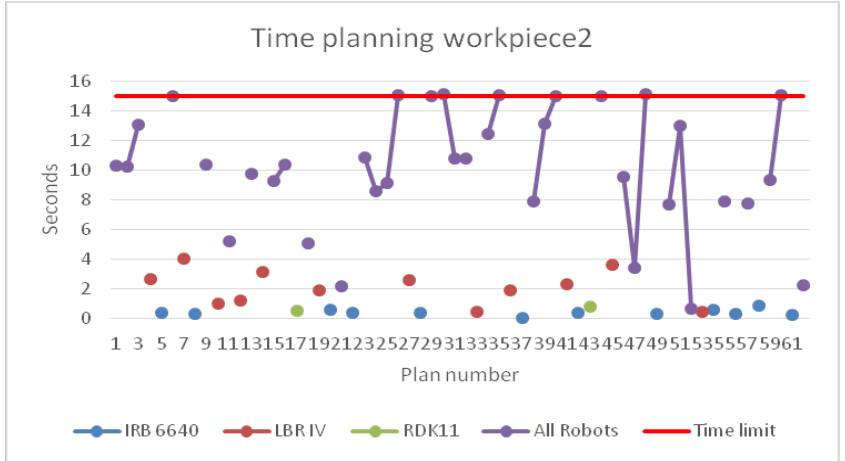
Figure 15. Time diagram of the planning procedure to weld <piece 2>.